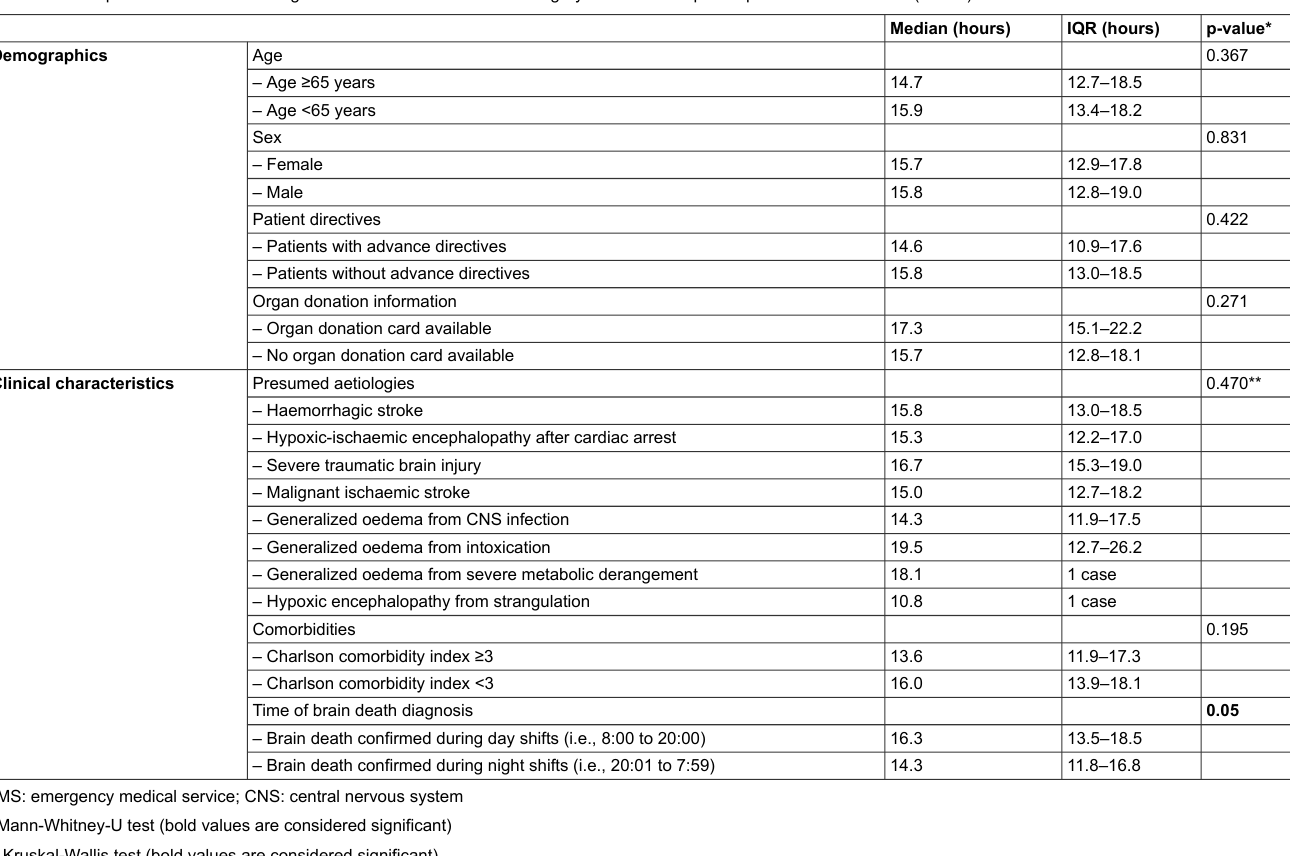
Table 3: Univariable comparisons of time from diagnosis of brain death to start of surgery in relation to specific patient characteristics (n =